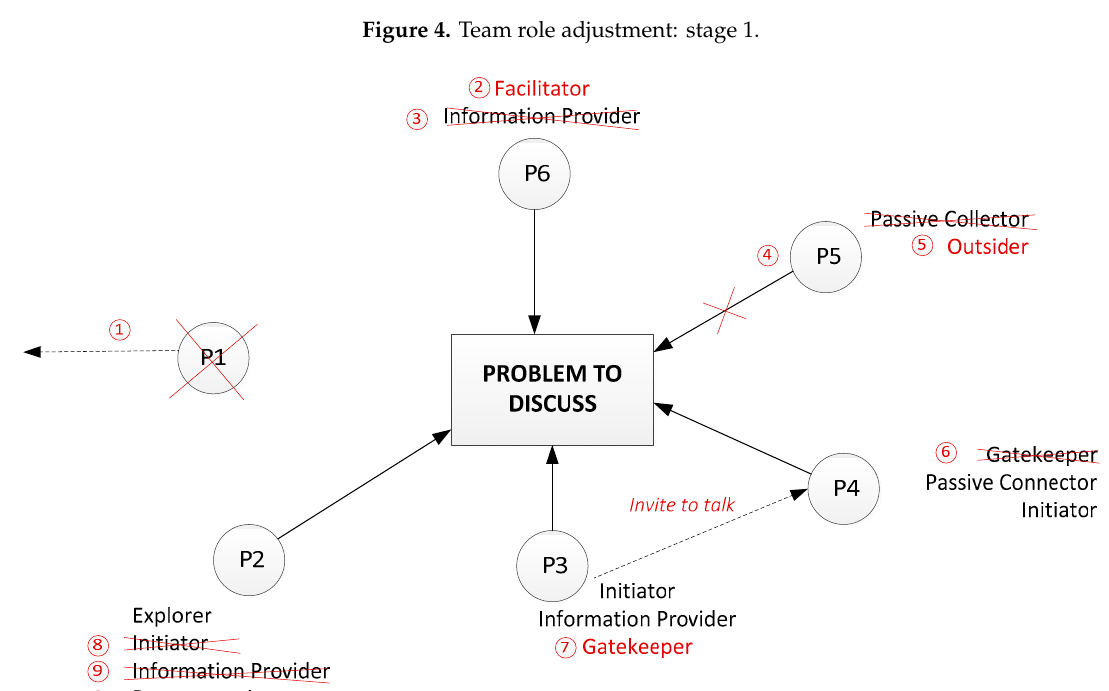
Figure 4. Team role adjustment: stage 1.